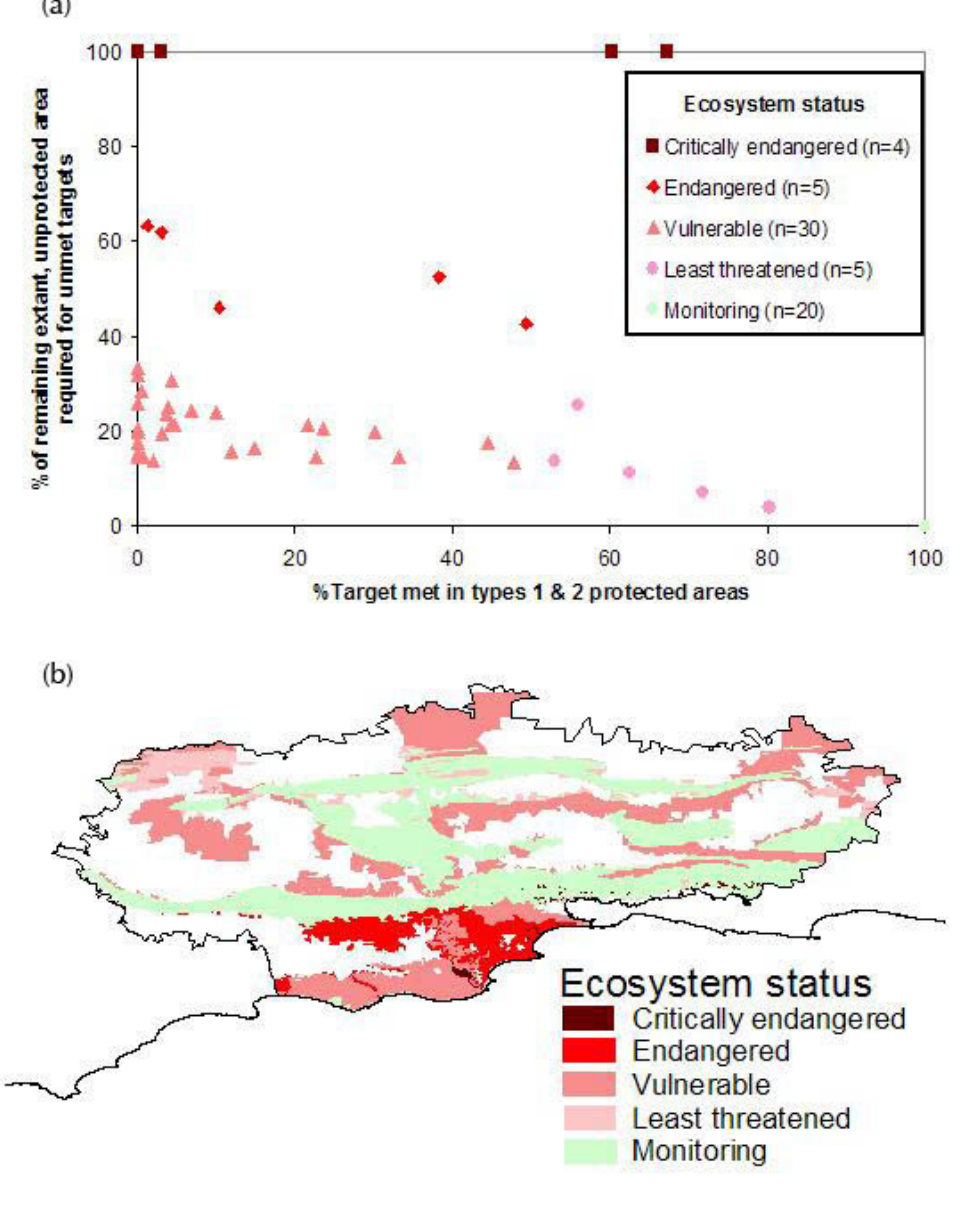
Fig. 3. The ecosystem status of each of the 64 vegetation types in the planning domain. In (a), the number of vegetation types in each category is listed in the legend. Note that 20 vegetation types meet their targets in protected areas (status = Monitoring), and thus all fall on the same, single symbol. Values are assigned to ecosystem status as follows: critically endangered = 4, endangered = 3, vulnerable = 2, least threatened = 1 and monitoring = 0. These values are used to calculate the biodiversity value in Figure 7a. Below, Fig. (b) shows the distribution of the ecosystem status of vegetation types within the corridor network